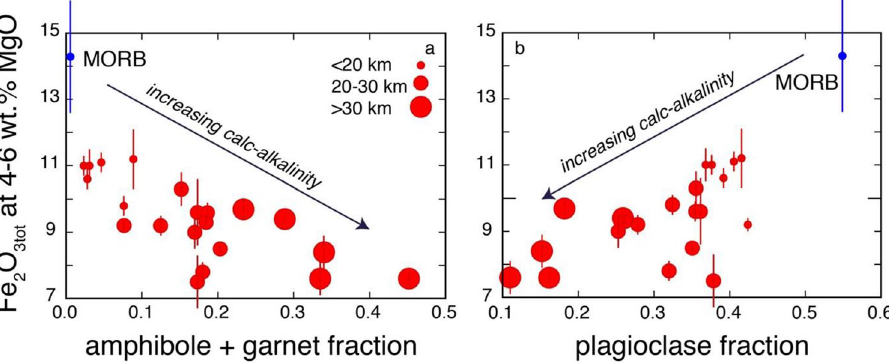
Figure 5. Proportions of mineral fractions versus tholeiitic character. ( a ) Proportions of fractionating amphibole + garnet versus the tholeiitic index (as defined by 7 ); ( b ) proportions of fractionating plagioclase versus the tholeiitic index (as defined by 7 ). Different circle sizes highlight different arc crust